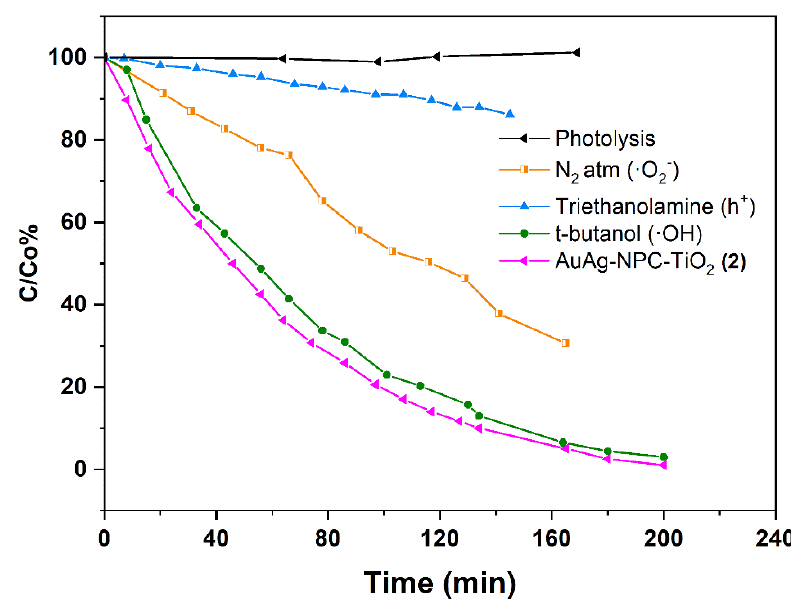
Figure 7. Evolution of CIP concentration during photocatalytic degradation with 2 under visible light irradiation and effect of scavengers.